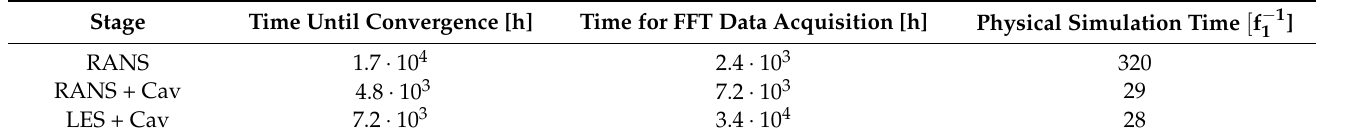
Table 1. Simulation stages with corresponding